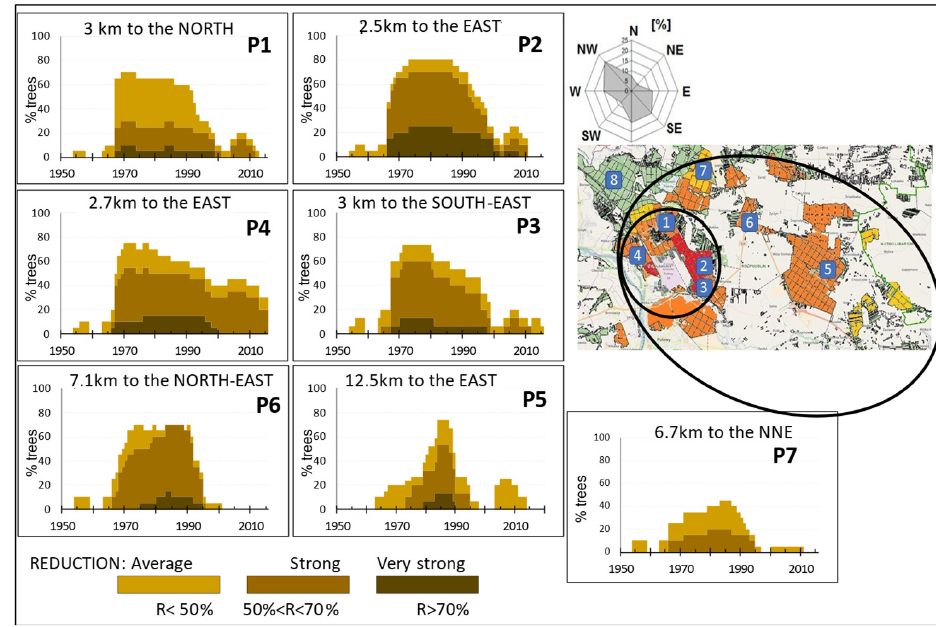
Figure 7. Graph showing growth reductions at the Scots pines in the different study plots.